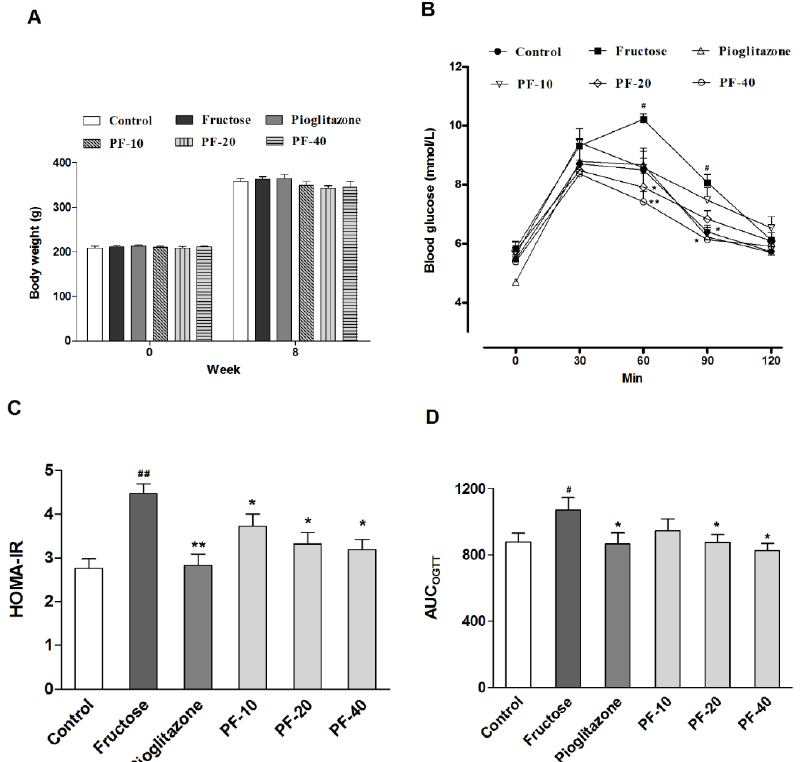
Figure 2. Effects of paeoniflorin on the body weight and insulin sensitivity in rats. Data are expressed as the mean ± SEM ( n = 8). ( A ) Body weight. ( B ) The oral glucose tolerance test. ( C ) The homeostasis model assessment insulin resistance index (HOMA-IR) index. ( D ) The area under curve during oral glucose tolerance test (OGTT). Data was analyzed by one-way ANOVA followed by Dunnett’s post hoc test. # p < 0.05 and ## p < 0.01 vs. control group. * p < 0.05 and ** p < 0.01 vs. fructose group. PF-10: 10 mg/kg of paeoniflorin; PF-20: 20 mg/kg of paeoniflorin; PF-40: 40 mg/kg of paeoniflorin. HOMA-IR: Homeostasis model assessment insulin resistance index; OGTT: Oral glucose tolerance test; AUC: Area under